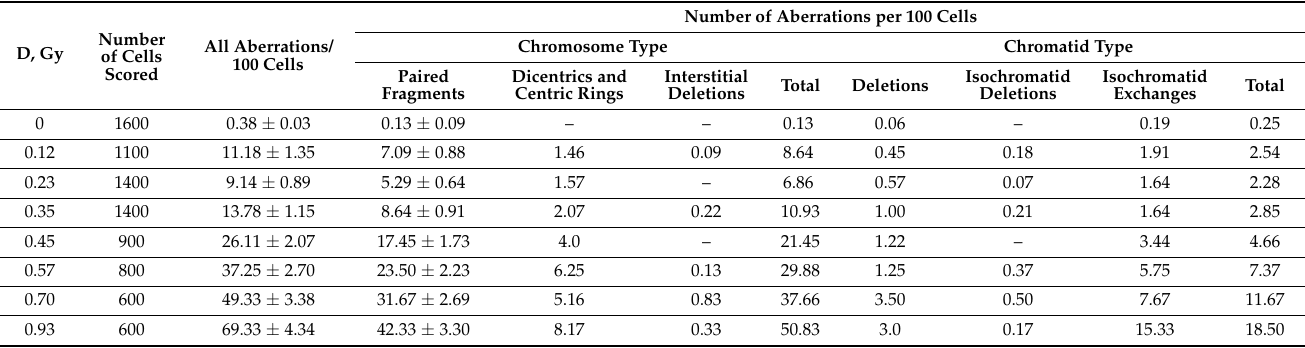
Table A5. Frequencies of chromosome aberrations induced in CHO-K1 cells by low doses of 12 C ions at Bragg curve